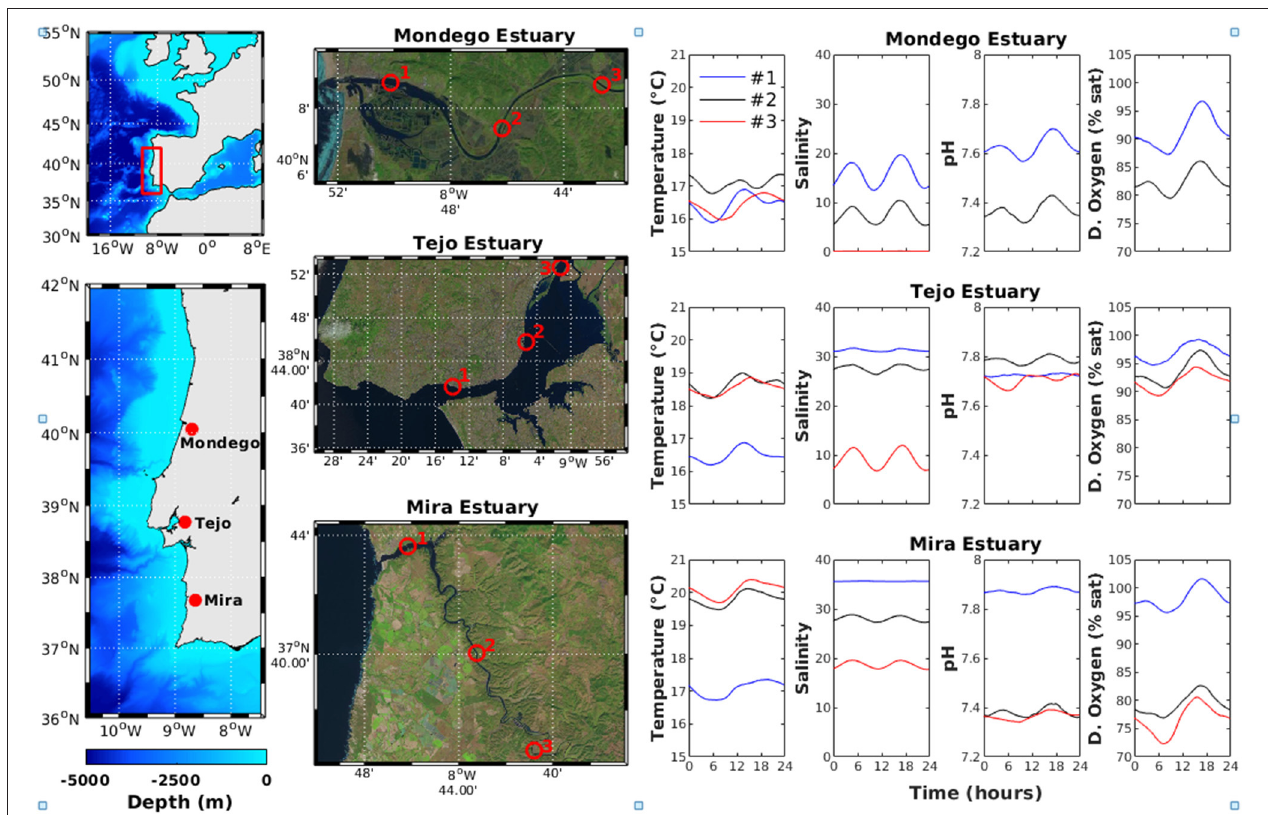
FIGURE 1 | Location of the three estuaries and the three sondes in each of them (left). Intraday means of Temperature, Salinity, pH and Oxygen (saat%) at buoys 1 to 3 (blue, black and redlines,